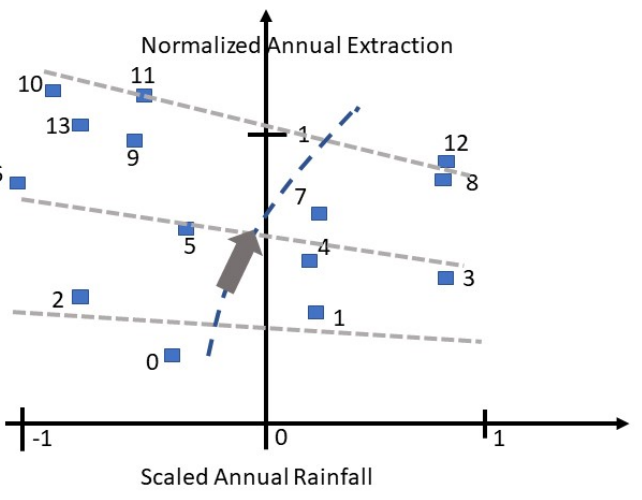
Figure 2. Schematic showing how relationships between groundwater extraction and rainfall over time can be conceptualized. The data labels show the number of years since 2003–2004, and the dotted line shows the trajectory of the trend line for groundwater extraction with rainfall over time. If extraction is increasing in time, there are upward shifts. By following a single rainfall value, e.g., x = 0 (the mean rainfall), the effect of rainfall variations is removed. Lower rainfall generally leads to increased extraction and hence there is a shift to the upper left-hand side for drier climates. A stable extraction cycle that is stable is represented by a stable trend line.